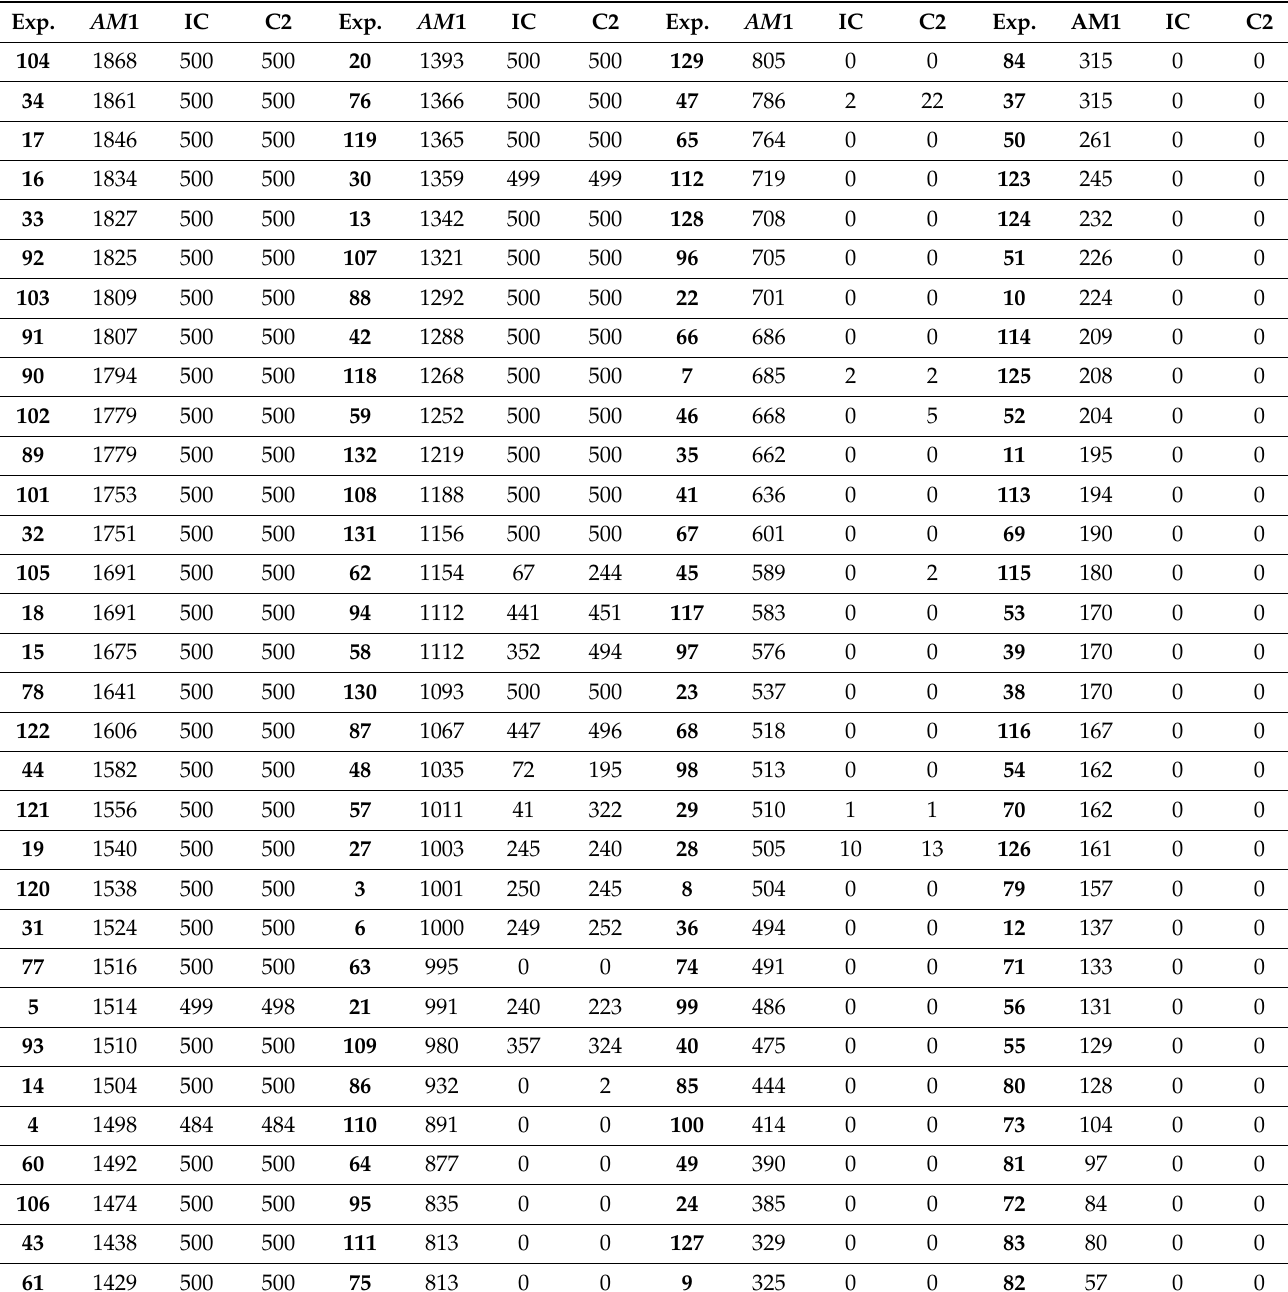
Table 5. Behaviour of the selection criteria in Case 2. N = 2000 1